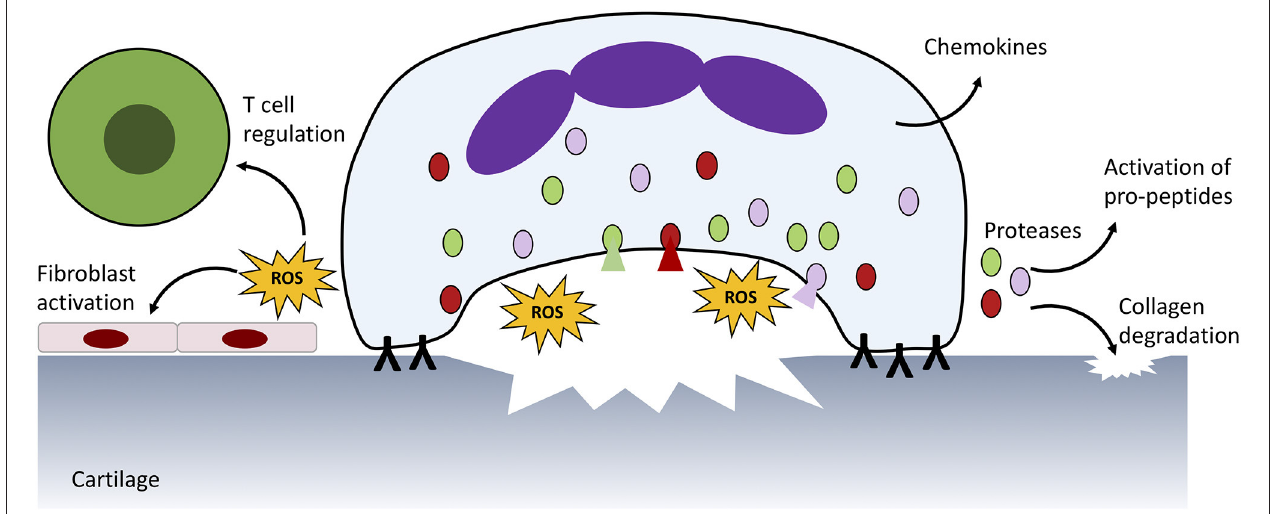
FIGURE 2 | Neutrophil ROS production and protease release damages host tissue. In RA, immune complexes on the surface of the joint activate ROS production and protease release from granules (shaded red, green, and pink) which damages underlying cartilage and activates neighbouring immune cells and fibroblasts. Proteases also activate pro-peptides, such as cytokines produced by neutrophils and other infiltrating immune cells. A similar process is responsible for damage to blood vessels in SLE.